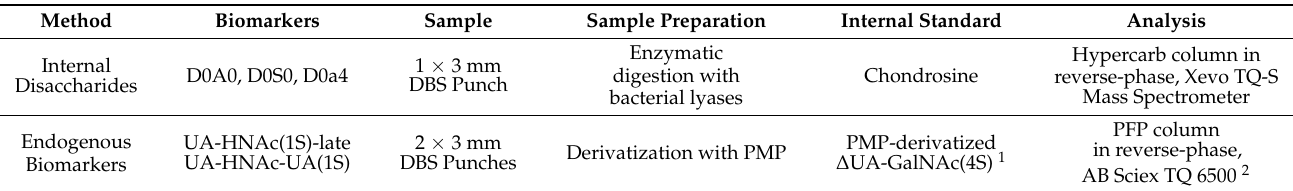
Table 1. Comparison of two glycosaminoglycan (GAG) analysis